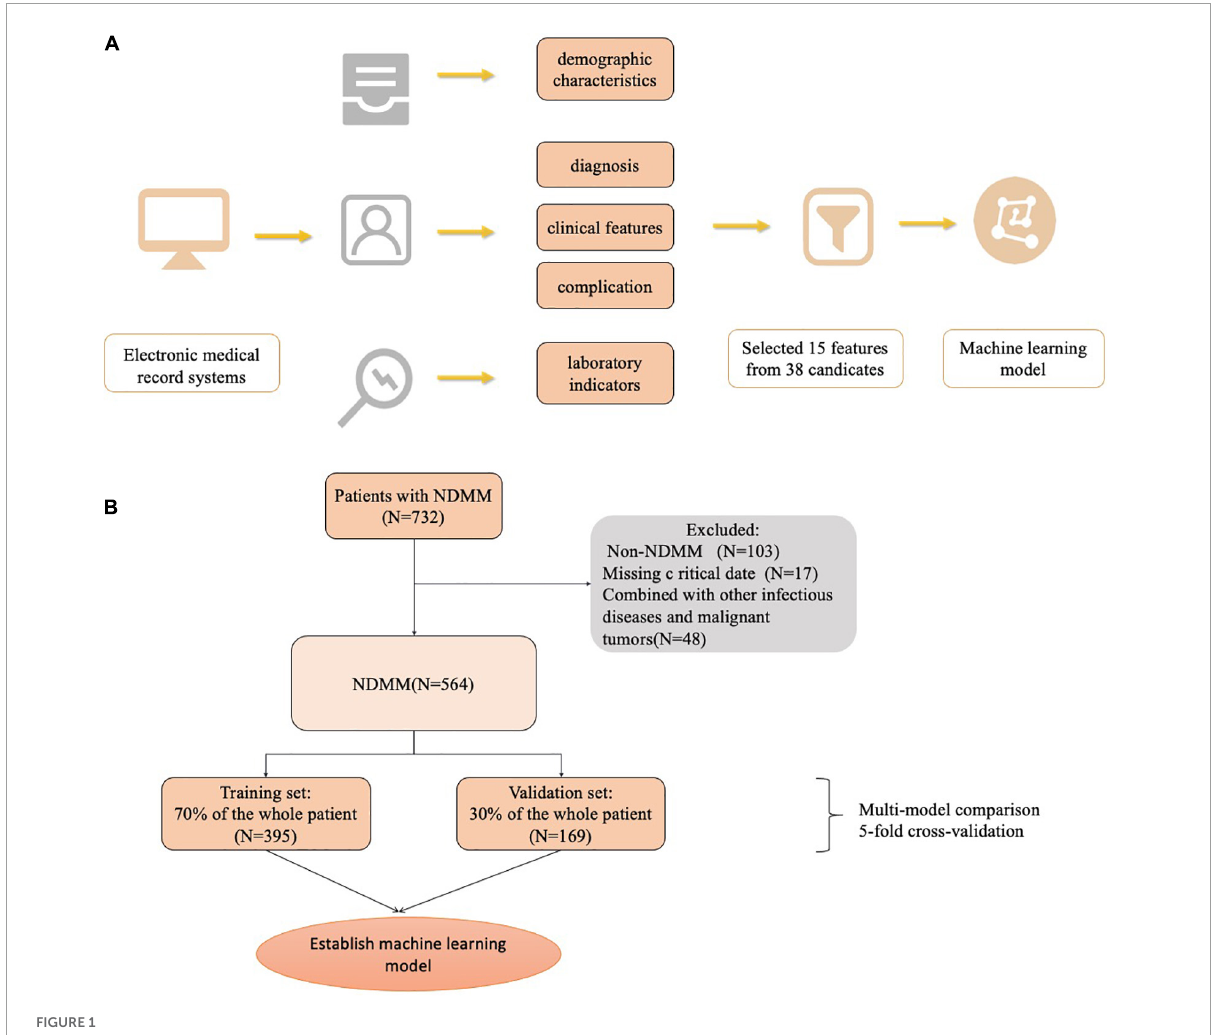
FIGURE1 The workflow diagram of this study.